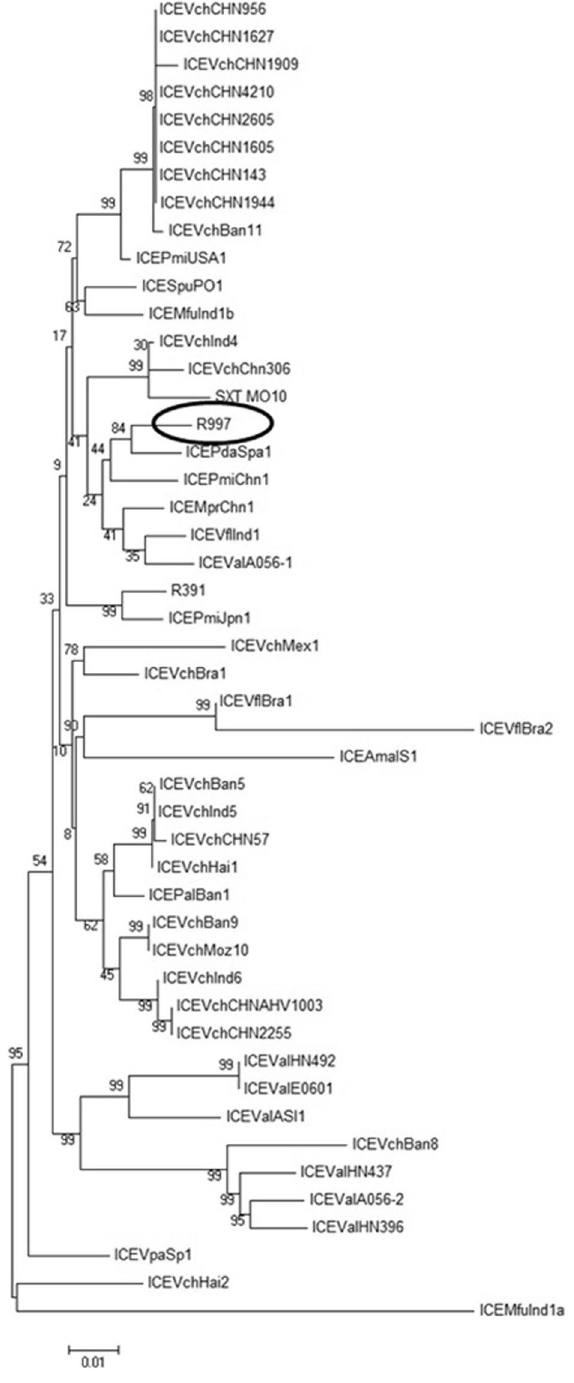
Figure 2. Phylogenetic tree from the maximum-likelihood analysis of the core concatenated proteins of 48 SXT/R391